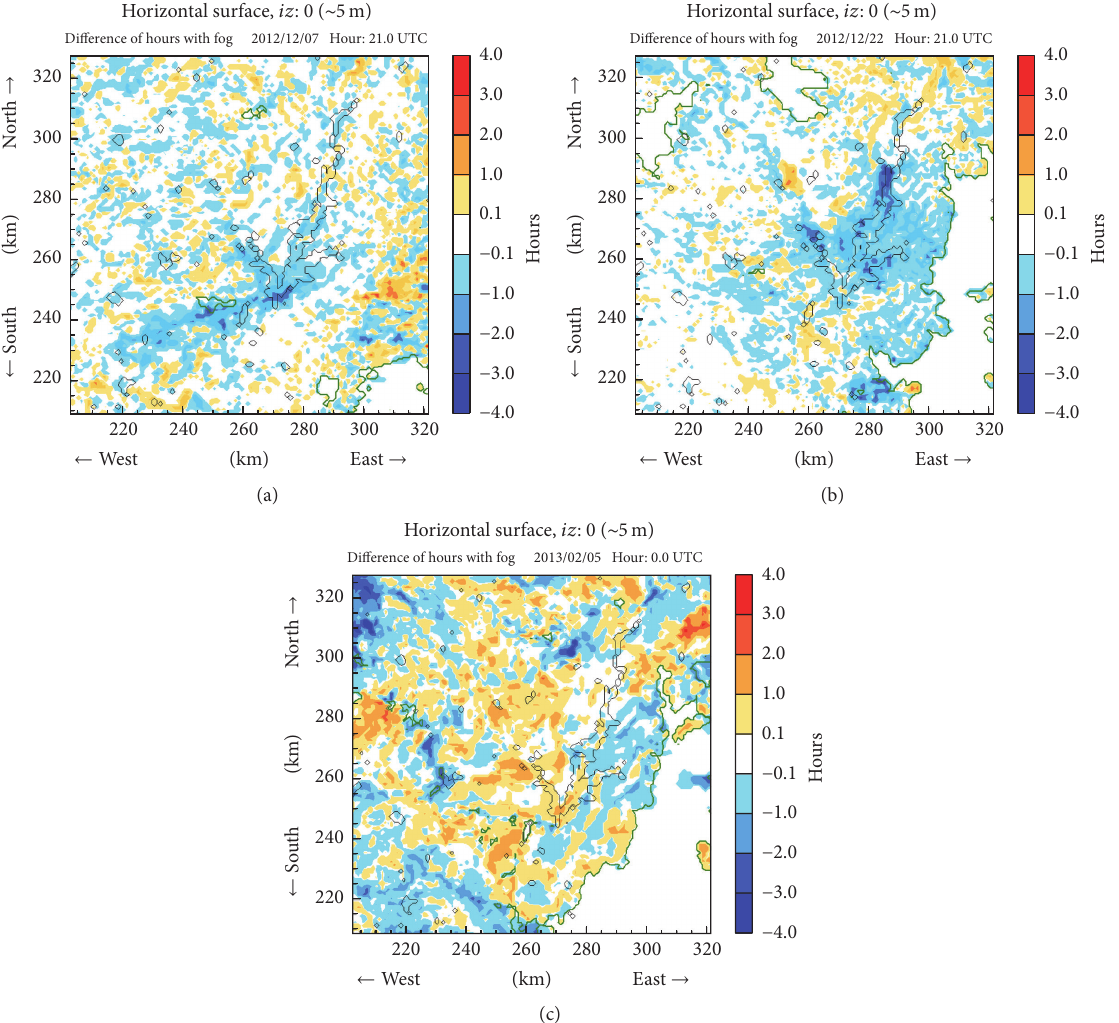
Difference of hours with fog 2012/12/07 Hour: 21.0 UTC